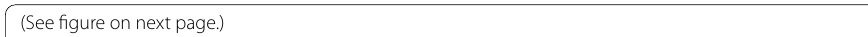
figure on next Fig. 6 ZNF674-AS1 antagonizes miR-423-3p to derepress p21. a Analysis of candidate miRNAs in NSCLC cells transfected with vector or ZNF674-AS1. * P < 0.05. ns: no significance. b Analysis of p21 mRNA levels after transfection with indicated constructs. * P < 0.05. c Western blot analysis of p21 protein levels in NSCLC cells treated as in ( b ). d MTT assay showed that ZNF674-AS1-mediated growth suppression was reversed by miR-423-3p. e Cell cycle analysis conducted in NSCLC cells transfected with indicated constructs. * P < 0.05 compared to vector-transfected cells; # P < 0.05 compared to cells transfected with ZNF674-AS1 alone. f An inverse correlation was detected between expression of ZNF674-AS1 and miR-423-3p in NSCLC specimens (n 83). g Schematic model of ZNF674-AS1/miR-423-3p/p21 =